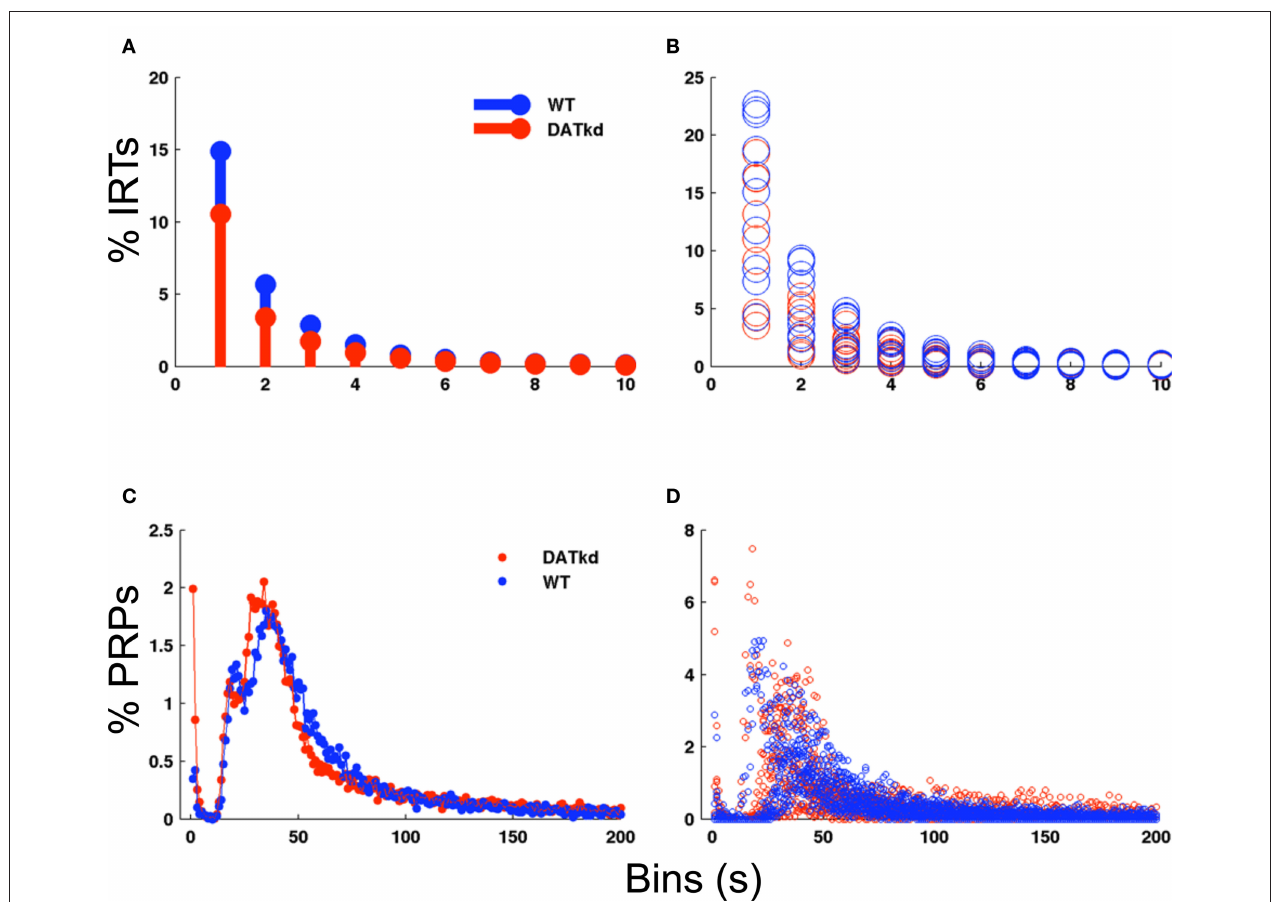
Figure 3 | inter-response times and post-reinforcement pauses across experiment. (A) Histogram of inter-response times (IRTs) in 1 s bins normalized to percentage of total IRTs for WT (blue bars) and DATkd (red bars) (genotype × bins, p = 0.0065). (B) Scatterplot of individual subject IRT